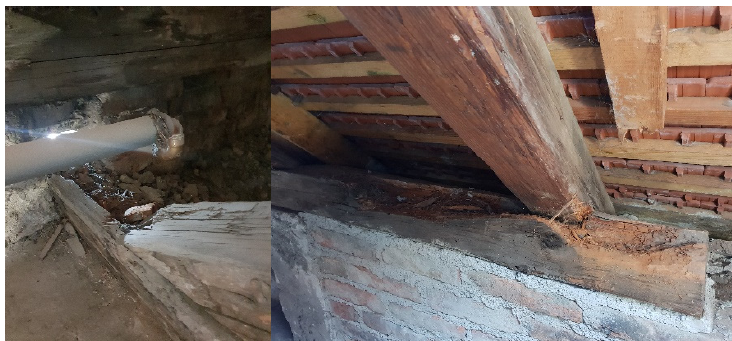
Figure 9. Damages to the timber roof structure due to ingress of moisture in combination with earth- quake impact. (Photo credit: Jure Barbali ć ).